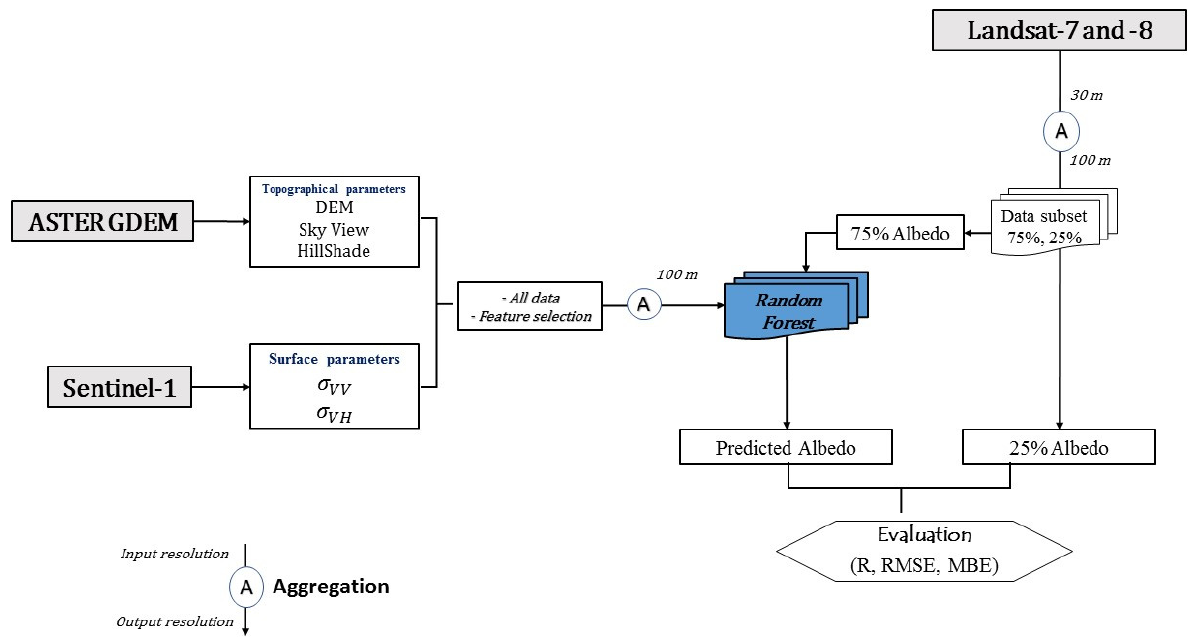
Figure 3. Flowchart showing the input and the outputs of the investigated approach. The approach to estimate α from radar data was compared against the α estimated from Landsat data using the correlation coefficient (R), bias (MBE), and root mean square error (RMSE). The calculation formulas for R, bias, and RMSE are as follows: